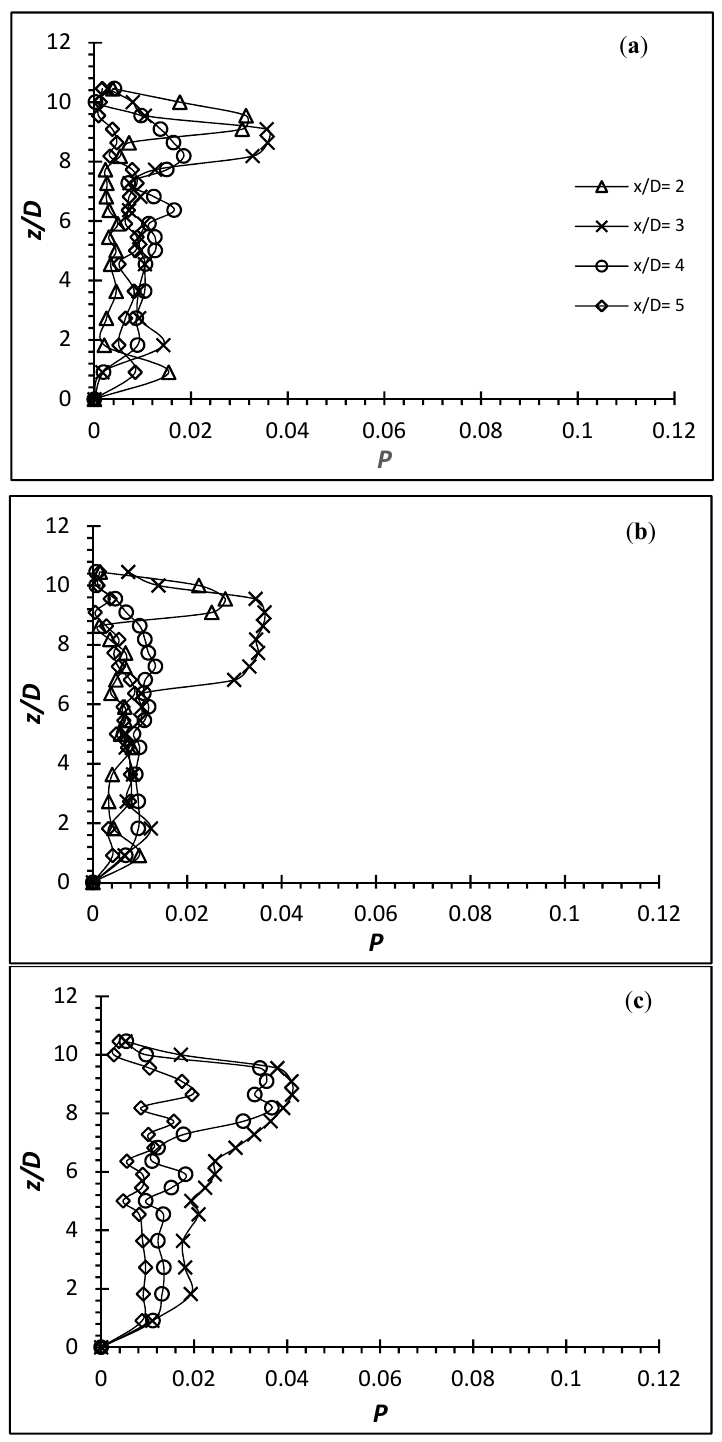
(cid:3105)(cid:3022) (cid:3284) ∂ U i u (cid:48) for flexible cylinder of AR = 10 at ( a ) Re = 4000; ( b ) Re = 6000; for flexible cylinder of AR = 10 at ( a ) Re = 4000; ( b ) Re = 6000; j i ∂ x j (cid:3105)(cid:3051) (cid:3285)